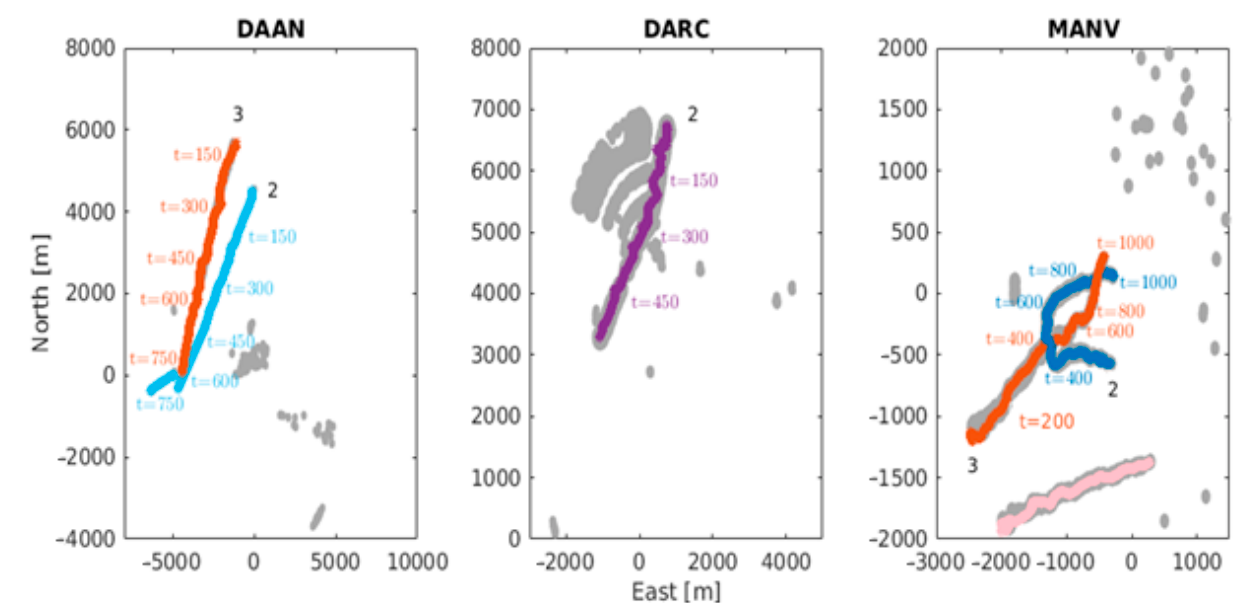
Figure 6. The estimated trajectories (coloured) and the radar point cloud measurements (grey dots) are shown following matching annotation and colour scheme from Figure 2 as convention. The observation steps are also printed for additional reference in the discussion.